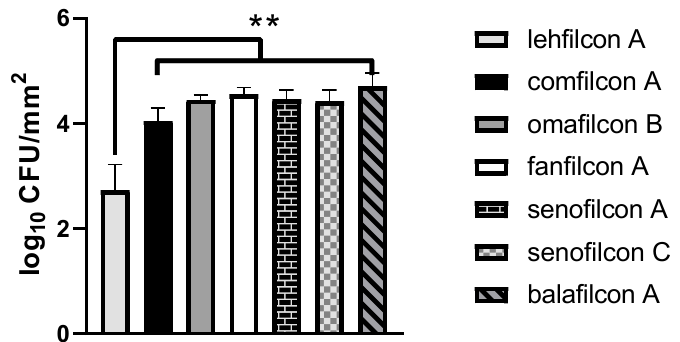
Figure 2. S. marcescens demonstrates low relative adhesion to lehfilcon A in low autofluorescence media. Adhesion assays of S. marcescens MCC 7246 exposed to soft contact lenses ( n = 8 per lens material) in MOPS minimal media supplemented with 10% FBS. The graph depicts the average log density of cells recovered after adhesion reactions (log CFU/mm 2 ± S.D.). ** indicates p < 0.0001 for comparison to lehfilcon A.